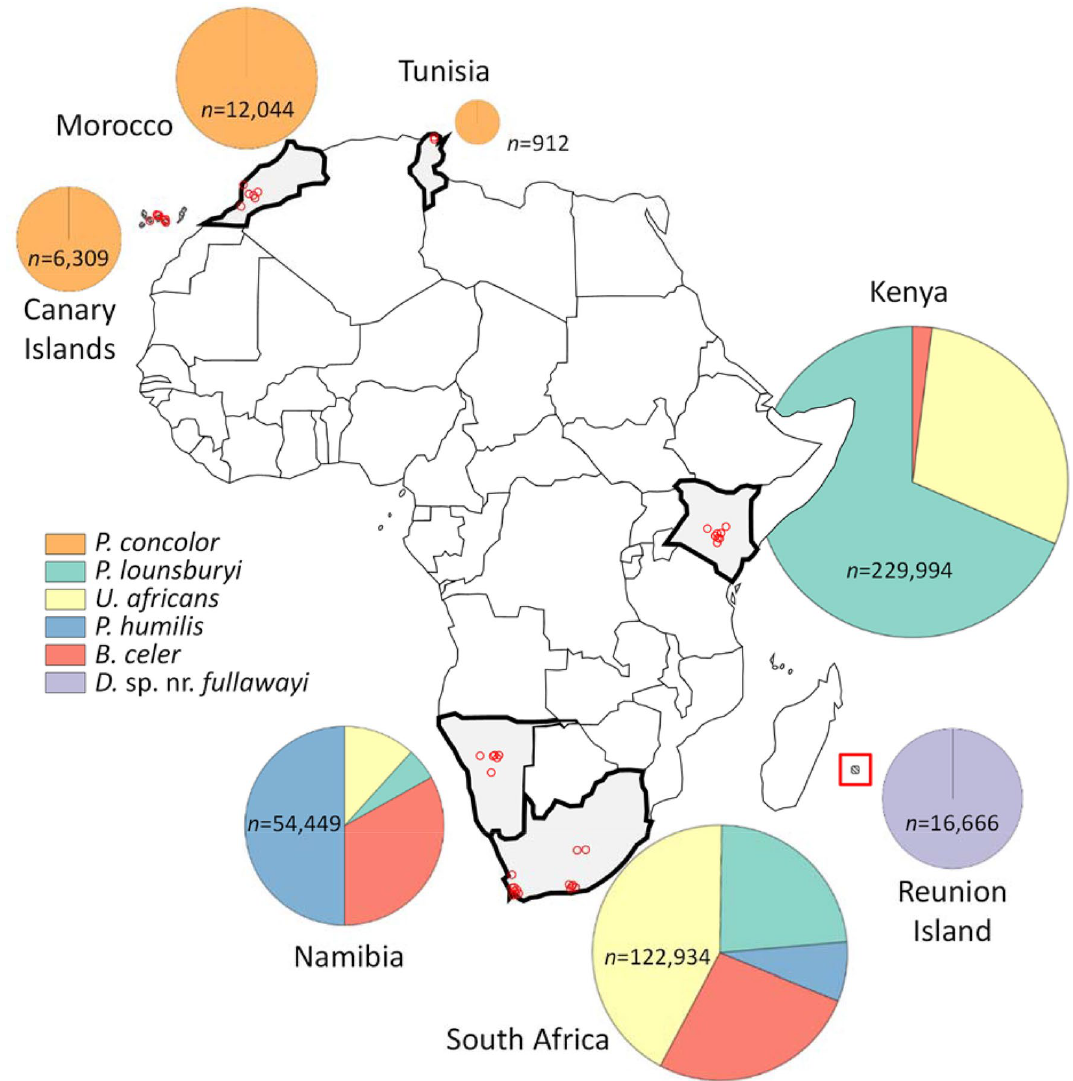
Figure 1. Composition and relative abundance (%) of braconid parasitoid species reared from Bactrocera spp. on wild olives in seven regions of Africa; small red circles show approximate locations of sampling sites and the parasitoid composition size is proportional to the number of fruits ( n ) collected in each region. The map was created in R (version 3.6.3) using ‘rworldmap’ package (version 1.3.6, https ://cran.r-proje ct.org/web/packa ges/ rworl dmap/rworl dmap.pdf) 69